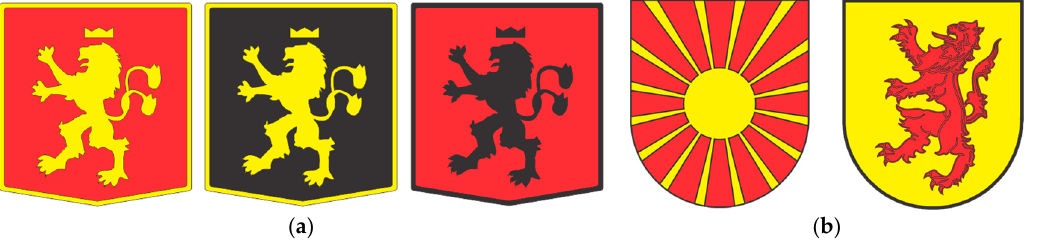
Figure 2. ( a ) Proposals by “FENIKS 92” 18 ; ( b ) Proposals by “MAKO”.